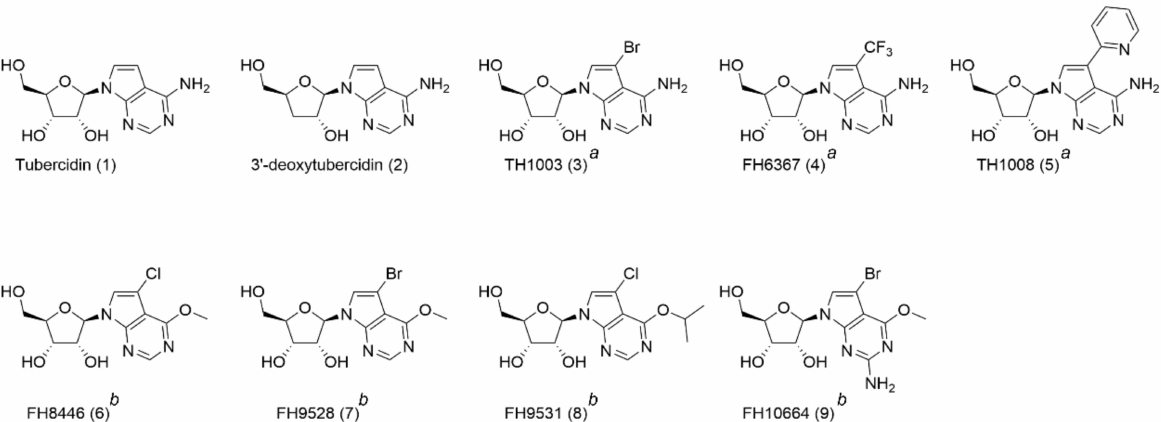
Figure 1. An overview of the nucleoside analogues used in this study. Compound name (compound code). a 7-deaza adenosine analogues. b inosine analogues. Compound codes in original publication: (Tubercidin (1), 3 (cid:48) -deoxytubercidin (9)) [20], (TH1003 (31), FH6367, TH1008 (13)) [19], (FH8446 (23), FH9531 (36), FH9528 (24), FH10664 (28))